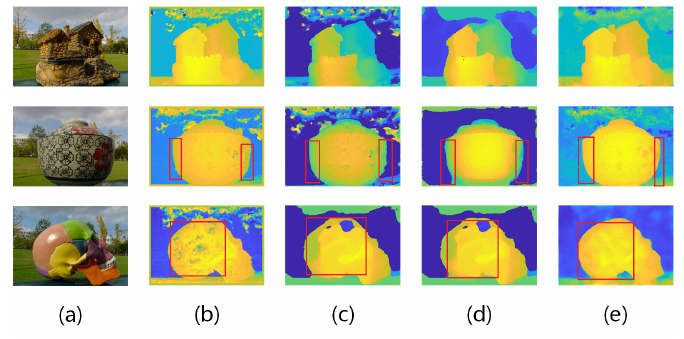
Figure 4. Lytro results. ( a ) thumbnail ; ( b ) [31]; ( c ) [8]; ( d ) [6]; ( e ) Ours(VommaNet).